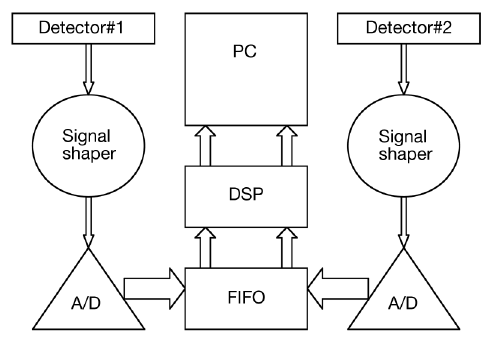
Fig. 2. MAS, electronic data stream: schematic lay- out.